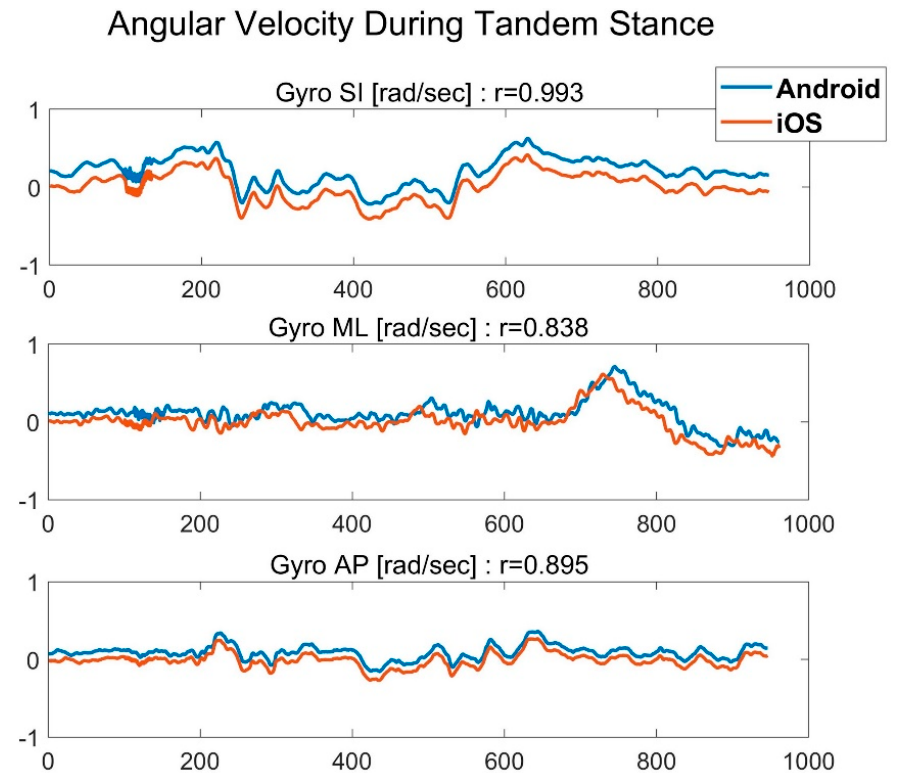
Figure 4. Cross-correlation between the raw signals, recorded with the gyroscope sensors of two smartphones with different operating systems, iOS (orange) and Android (blue), during tandem stance performance, with devices located on the participant’s sternum.